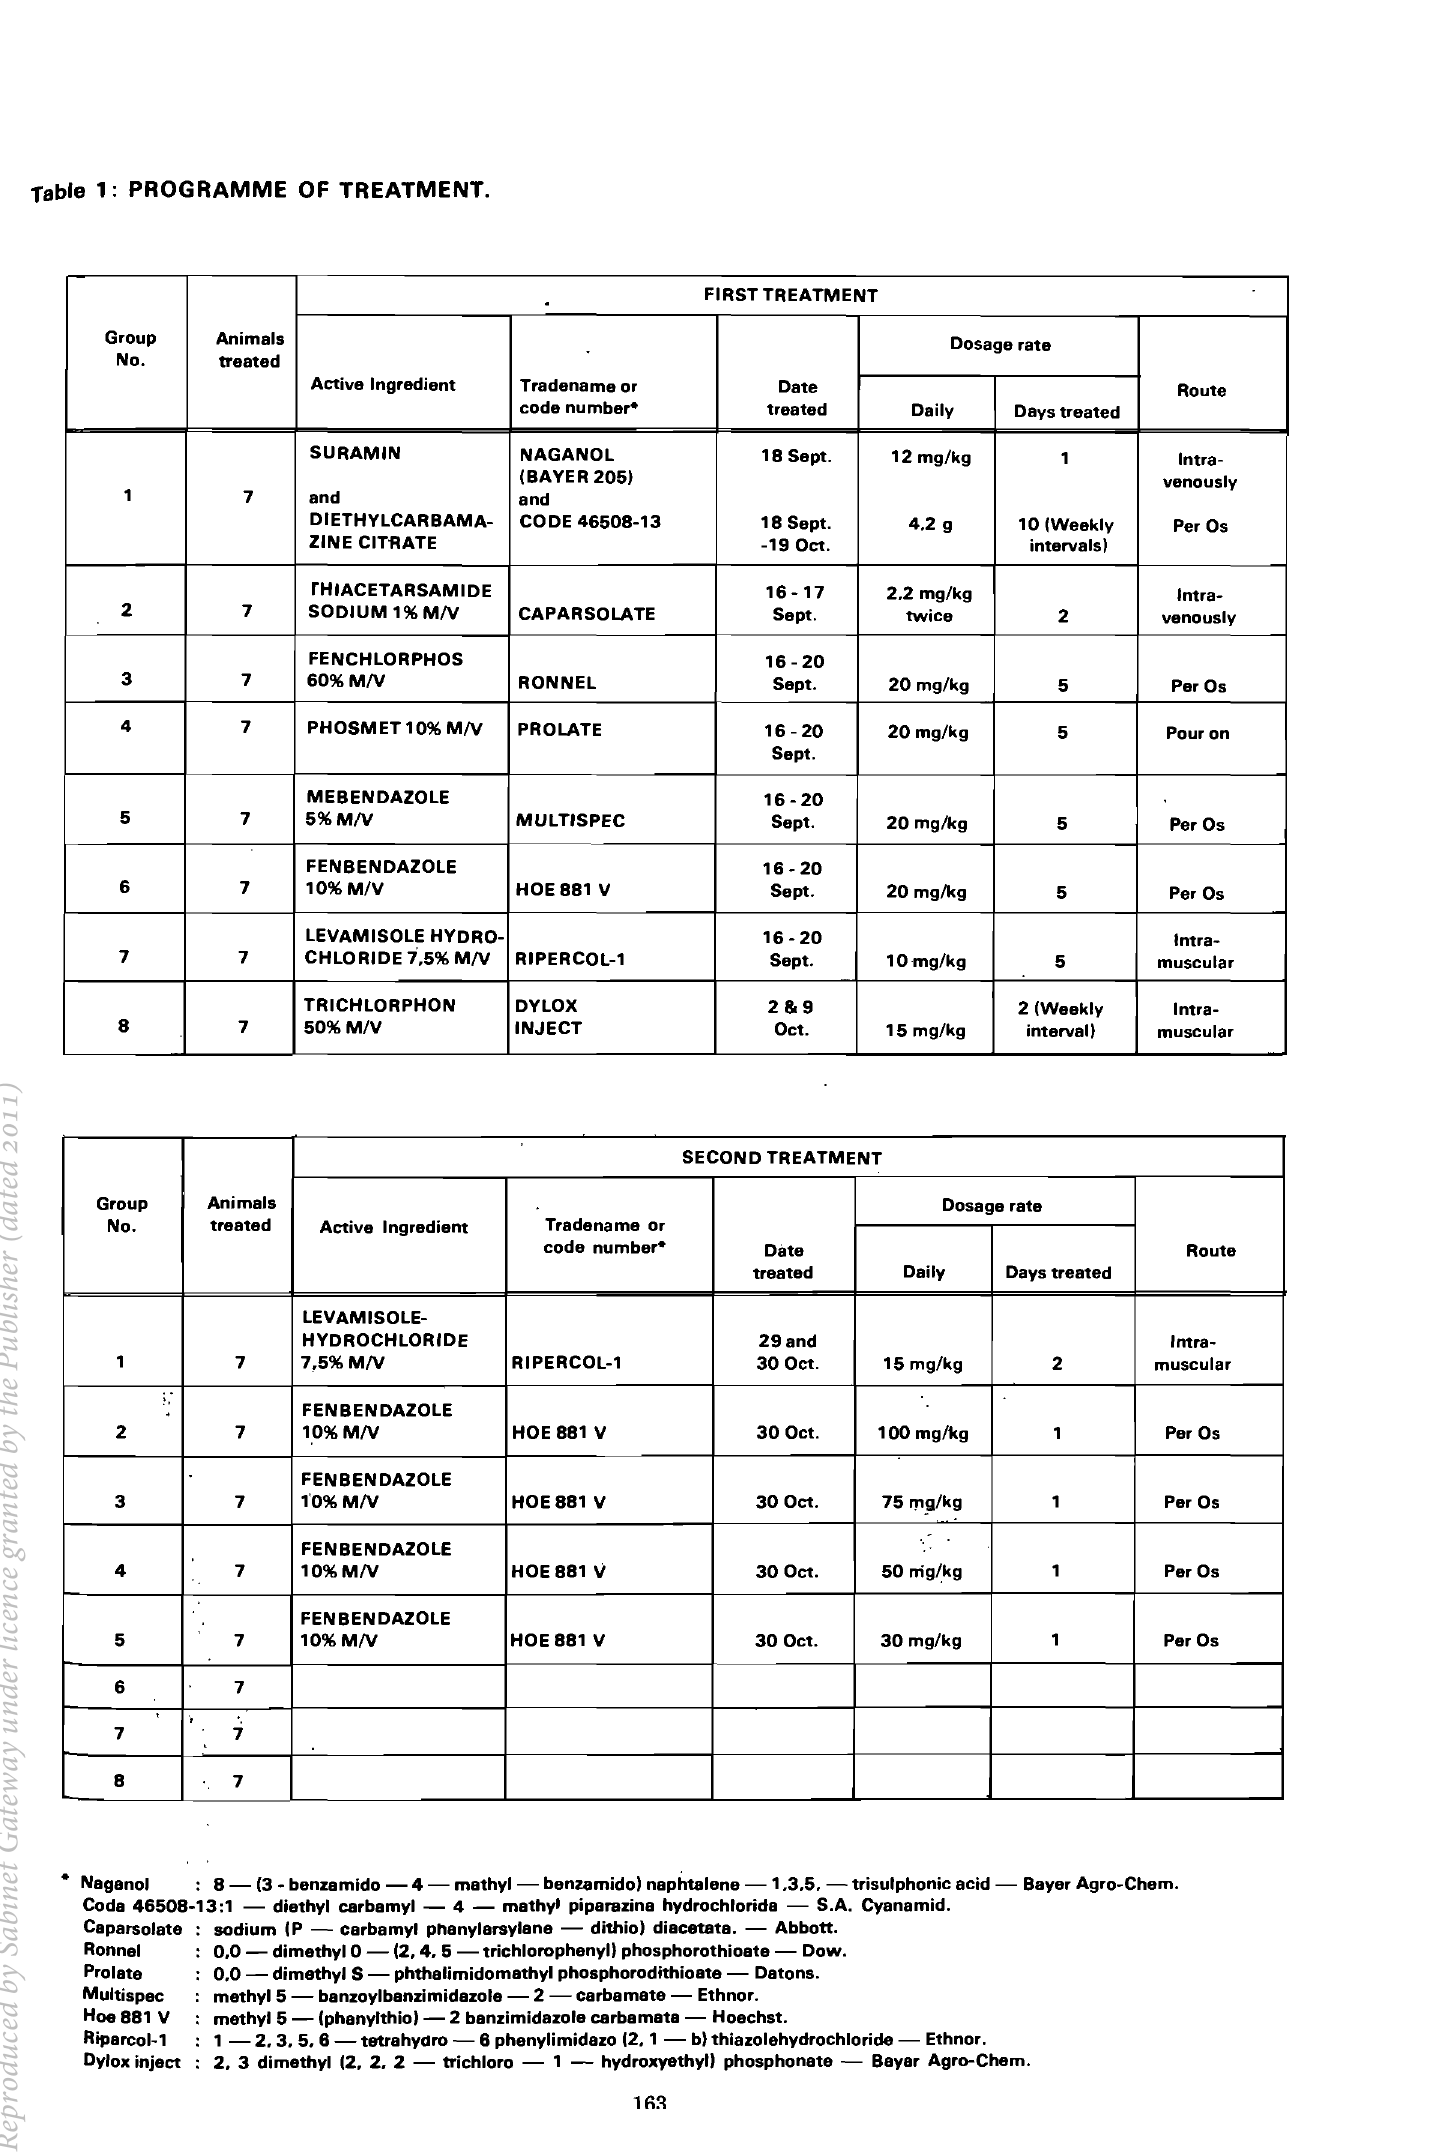
: 8 - (3 - benzemido - 4 - methyl - benzemido) nephtalene - 1.3.5. - trisulphonic acid - Bayer Agro-Chem. Code 46508-13:1 - diethyl carbemyl - 4 - methyl piperazine hydrochloride - S.A. Cyanamid. Ceparsolate sodium (P - cerbamyl pnenylersylene - dithio) diecetate. - Abbott. Ronnel 0.0 - dimethyl 0 - (2. 4. 5 - trichlorophenyl) phosphorothioete - Dow. Prolete 0.0 - dimethyl S - phthelimidomethyl phosphorodithioete - Detons. Multispec methyl 5 - benzoylbenzimidezole - 2 - cerbemete - Ethnor. Hoe 881 V methyl 5 - (phenylthio) - 2 benzimidazole carbemete - Hoechst. Ripercol-1 1 - 2. 3.5.6 - tetrehyaro - 6 phenylimidezo (2. 1 - b) thiazolehydrochloride - Ethnor. Dylox inject